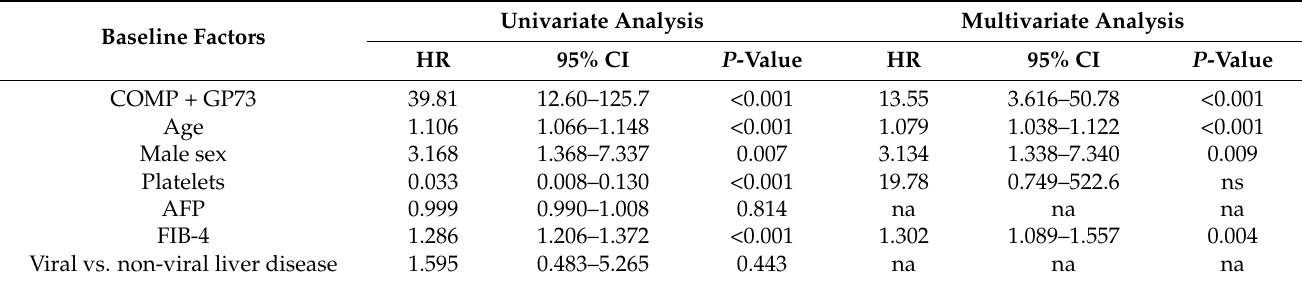
Table 3. Baseline factors associated with HCC development during